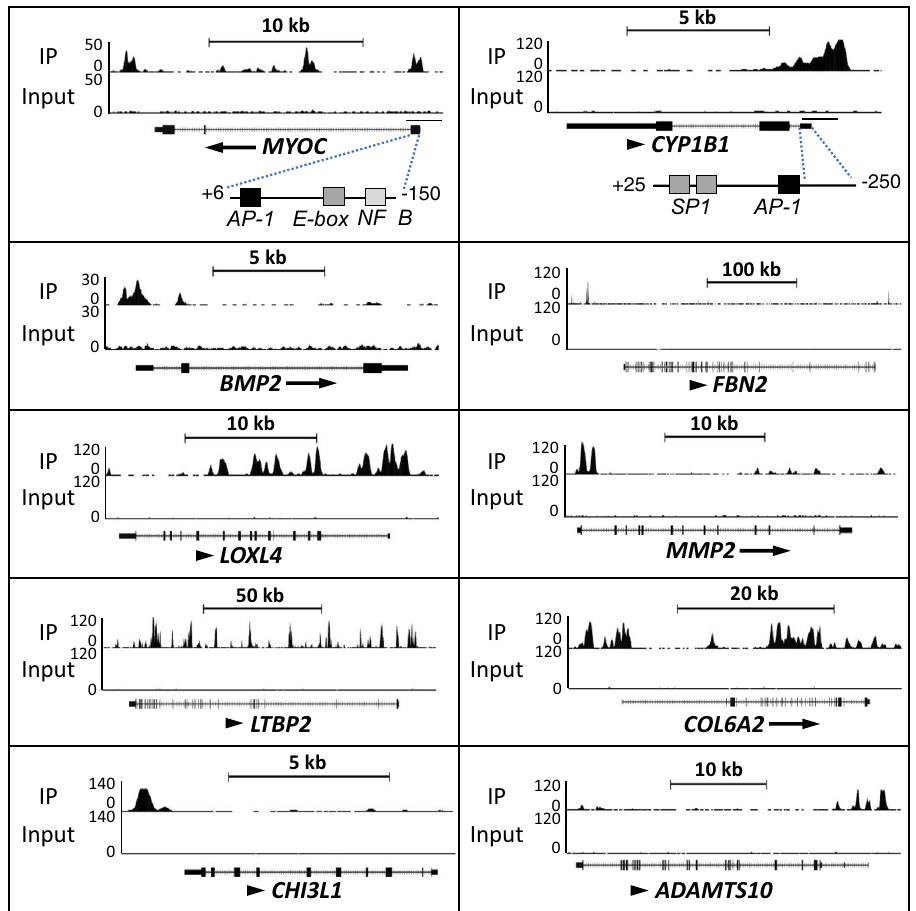
Fig. 6 Genome browser tracks of the MYOC, CHI3L1, BMP2, FBN2, LOXL4, MMP2, LTBP2, COL6A2, CYP1B1, and ADAMTS10 genes (https://genome. ucsc.edu/) showing GLIS1 occupancy (ChIP-Seq) in TM5(pIND-GLIS1) cells expressing Flag-GLIS1-HA. The AP-1, E-box, and NF κ B binding sites in MYOC and the AP-1 and G/C-rich SP1-binding sites in the CYP1B1 proximal promoter region are indicated.